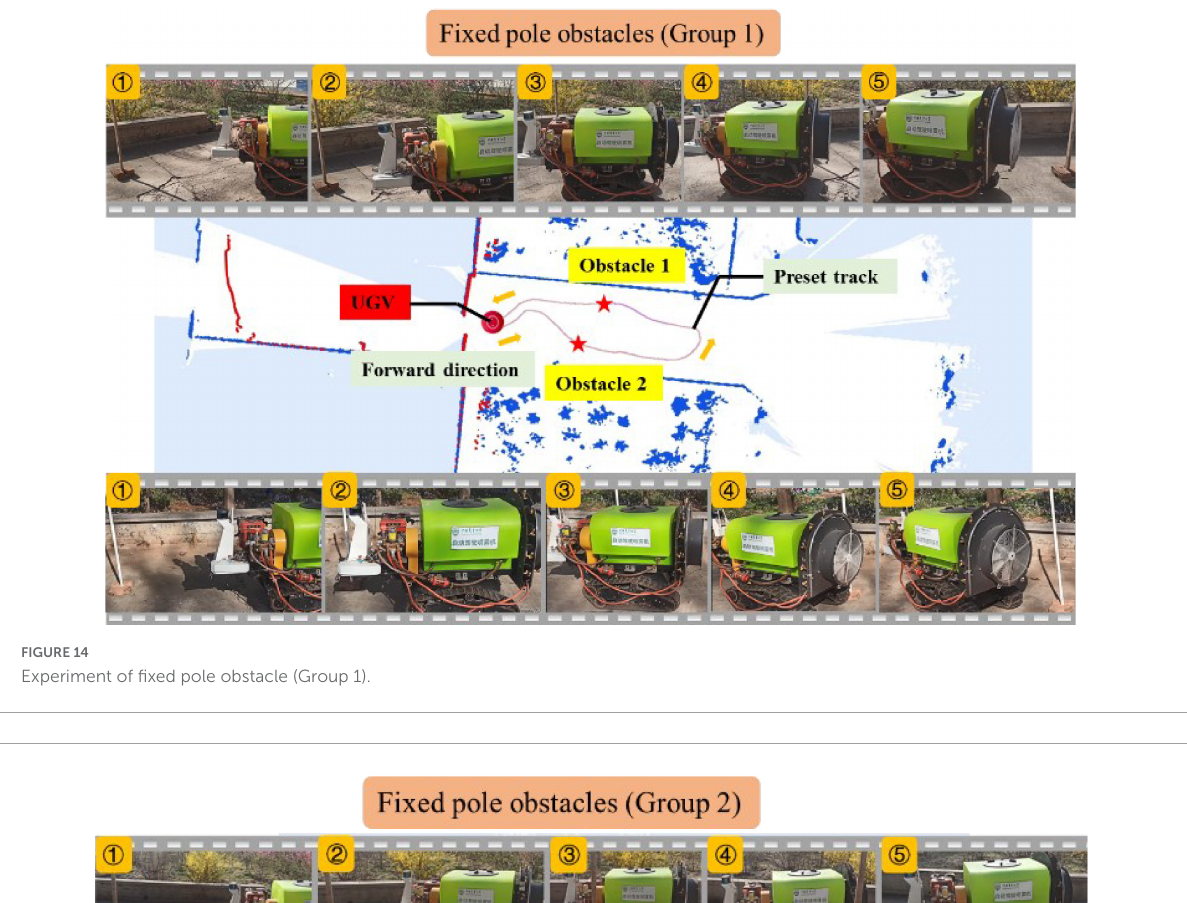
FIGURE14 Experiment of fixed pole obstacle (Group 1).